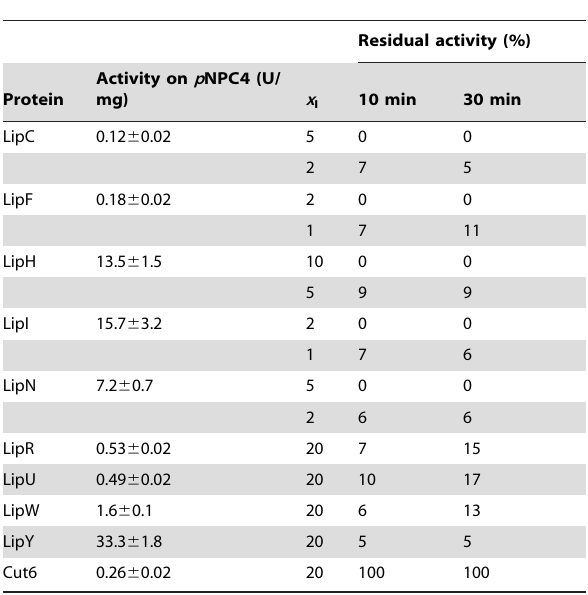
Table 2. Inhibition studies using M m